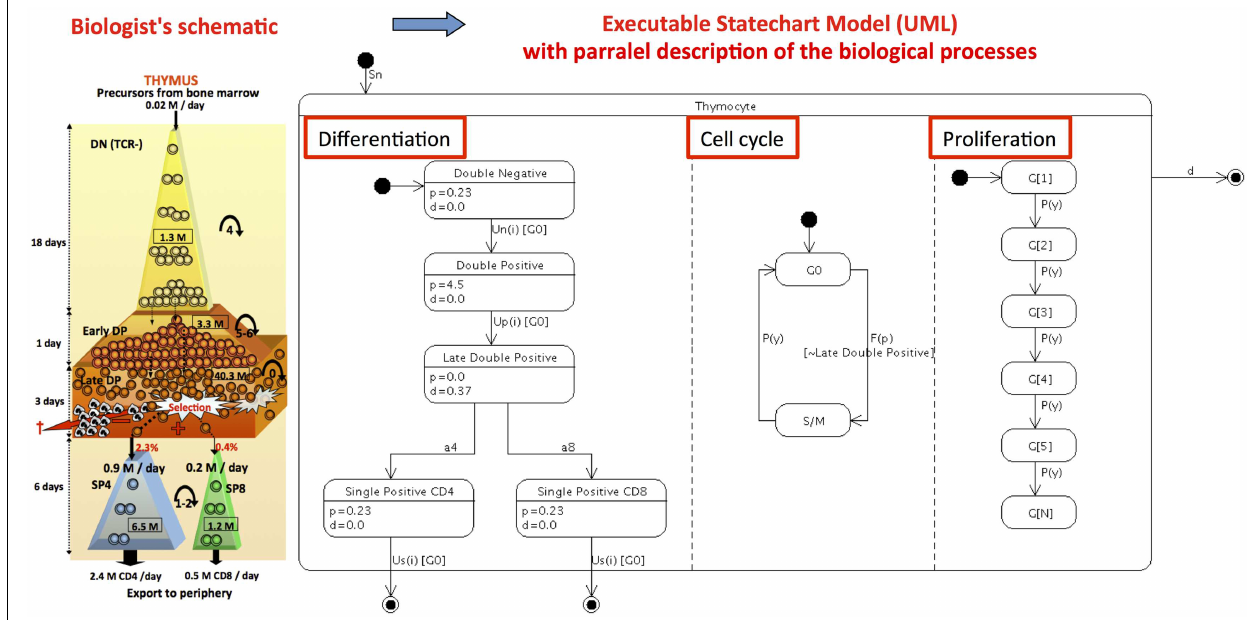
FIGURE 1 | Refactoring the continuous population (ODE) conveyor-belt model of thymocyte differentiation (8) into a computer executable visual language:The «biological schema »of thymocyte dynamics originally proposed is transformed into a UML state-transition diagram .This diagram represents the evolution of cell populations in the thymus, represented by their state from DN to SP, with UML figuration of the input